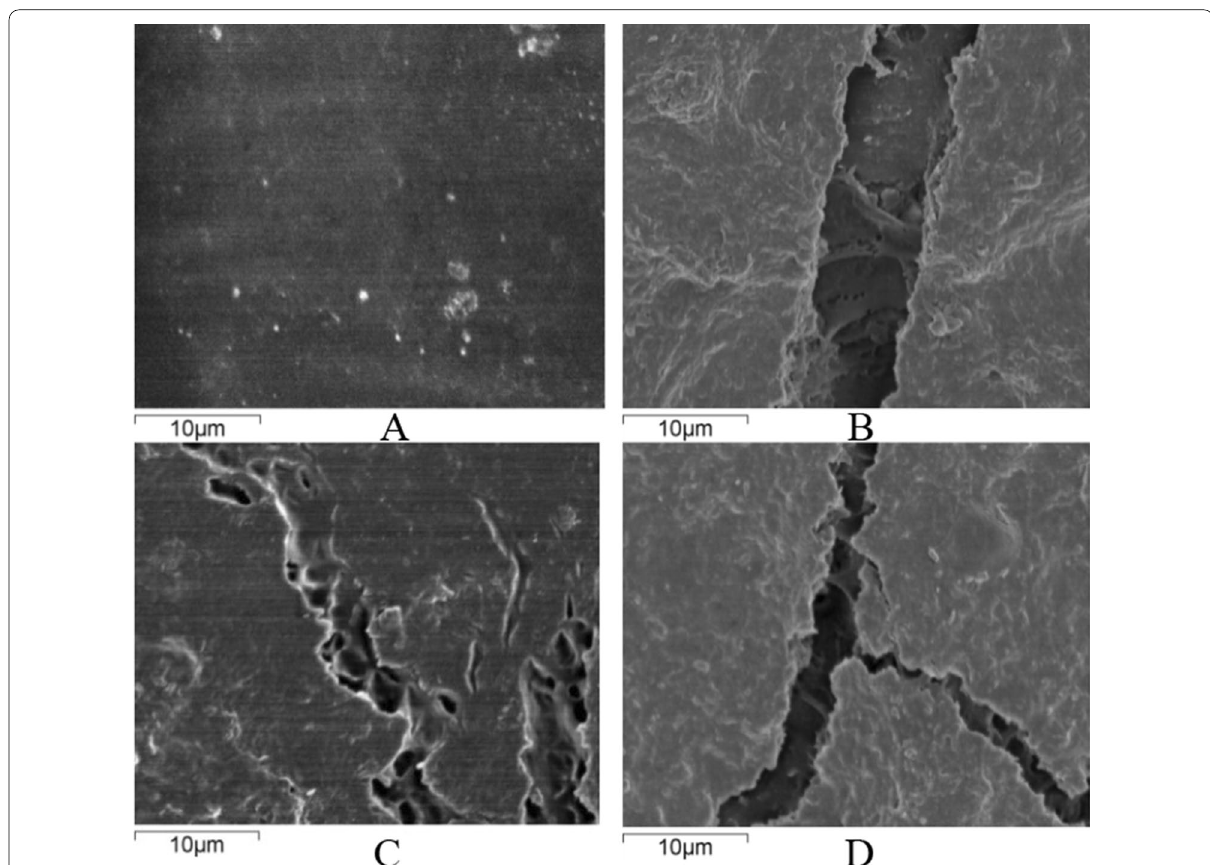
Fig. 2 Scanning electron microscopy to observe the surface of the HTPB sample with the bacterial membranes removed ( A shows the uncorroded HTPB material. B – D Show the corrosion effects on the surface of the HTPB material after microbial